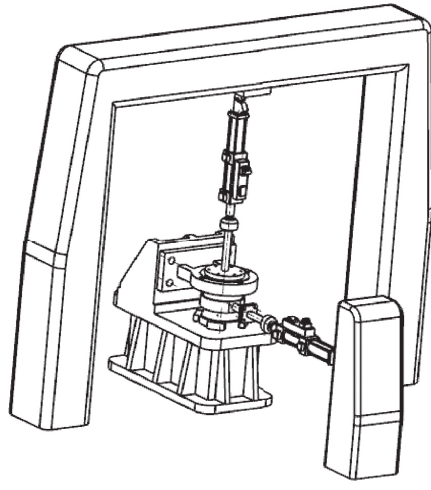
Figure 3: Test equipment.